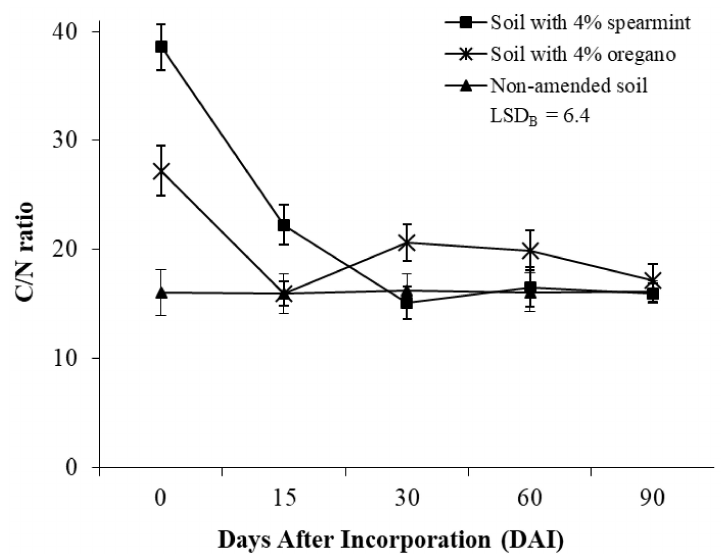
Figure 2. Changes in the C / N ratio in soil samples taken at di ff erent sampling times after the incorporation of 4% (w:w) spearmint or oregano plant material and in non-amended soil. Full description of the treatments examined is found in Table